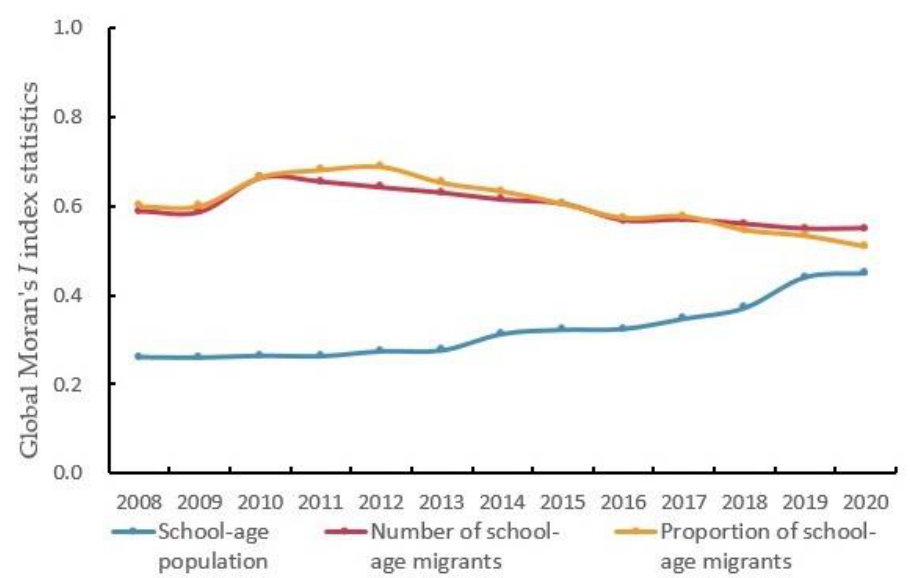
Figure 3. Spatial autocorrelation of the number and proportion of school-age migrants in Liaoning Province according to Global Moran ’ s I.